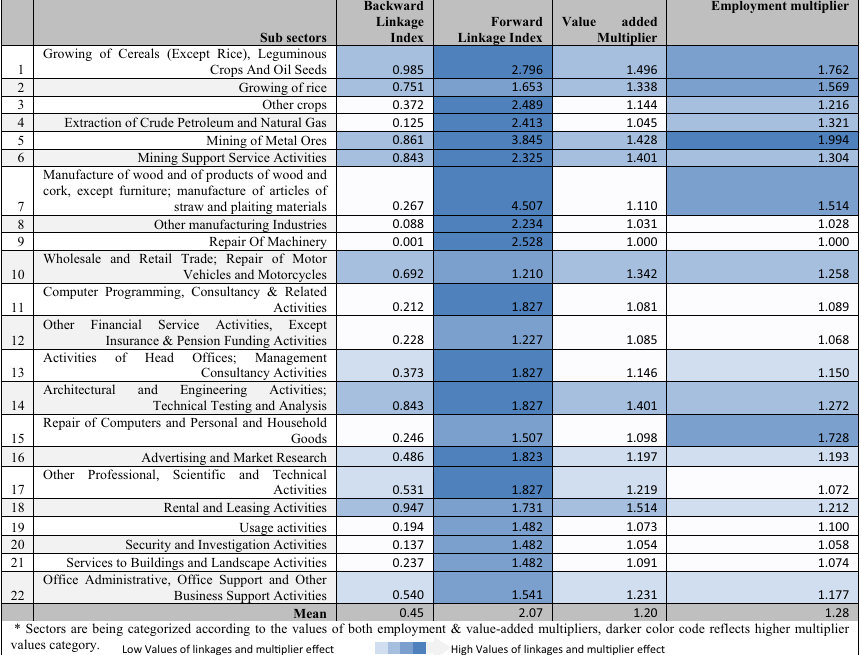
Figure 2. Sectors with